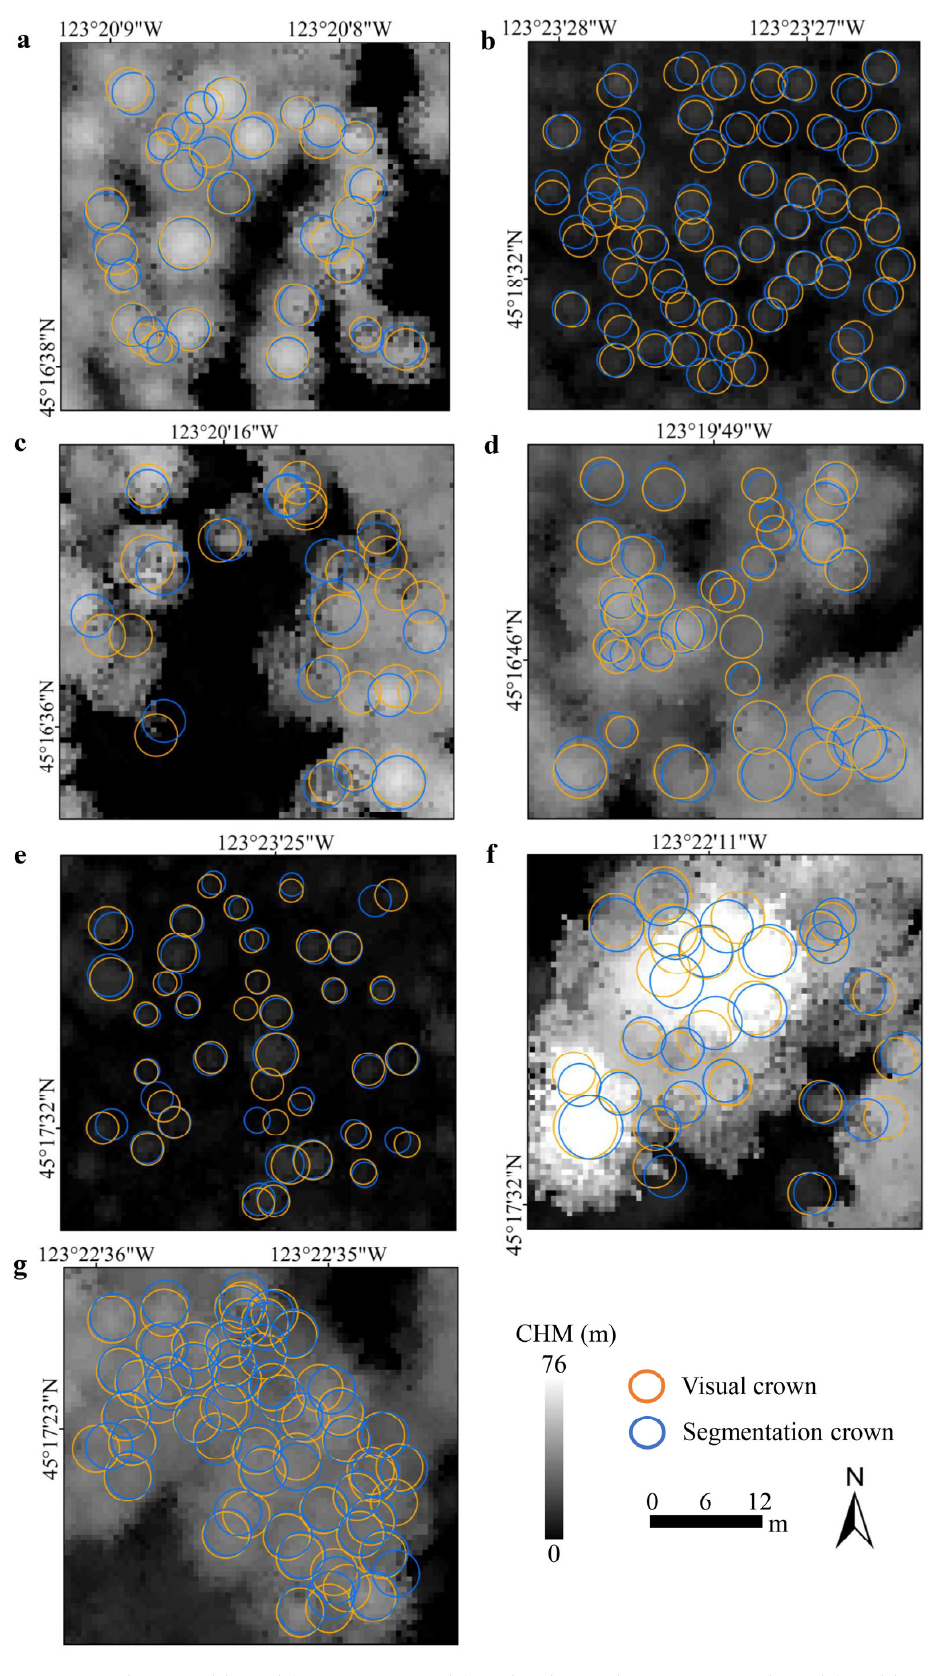
Figure 10. The visual-based (i.e., orange circle) and airborne-laser-scanning-based (i.e., blue circle) tree-crown-segmentation results with canopy height model (CHM) in the seven types of forest